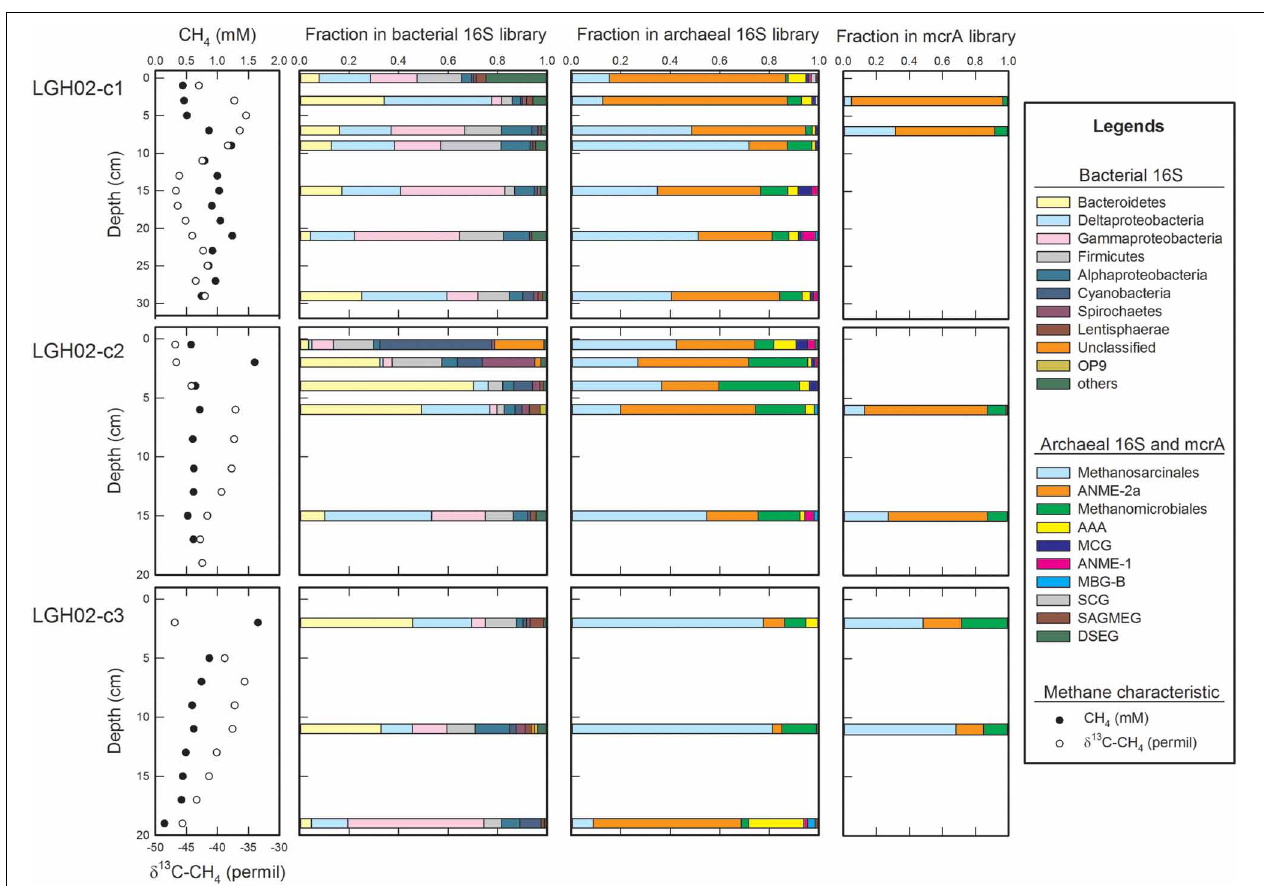
FIGURE 3 | Community structures along depth on the basis of 16S rRNA and mcrA genesequences. Profilesofmethaneconcentrations and δ 13 C-CH 4 values are shown for constraining methanogenic and methanotrophic zones. Abundancesofbacterialphyla/divisionslessthan1%ofthecommunitysizeare summed and categorized as “others.” The “Methanosarcinales” represents the sequences affiliated with the ANME-2-excluded Methanosarcinales